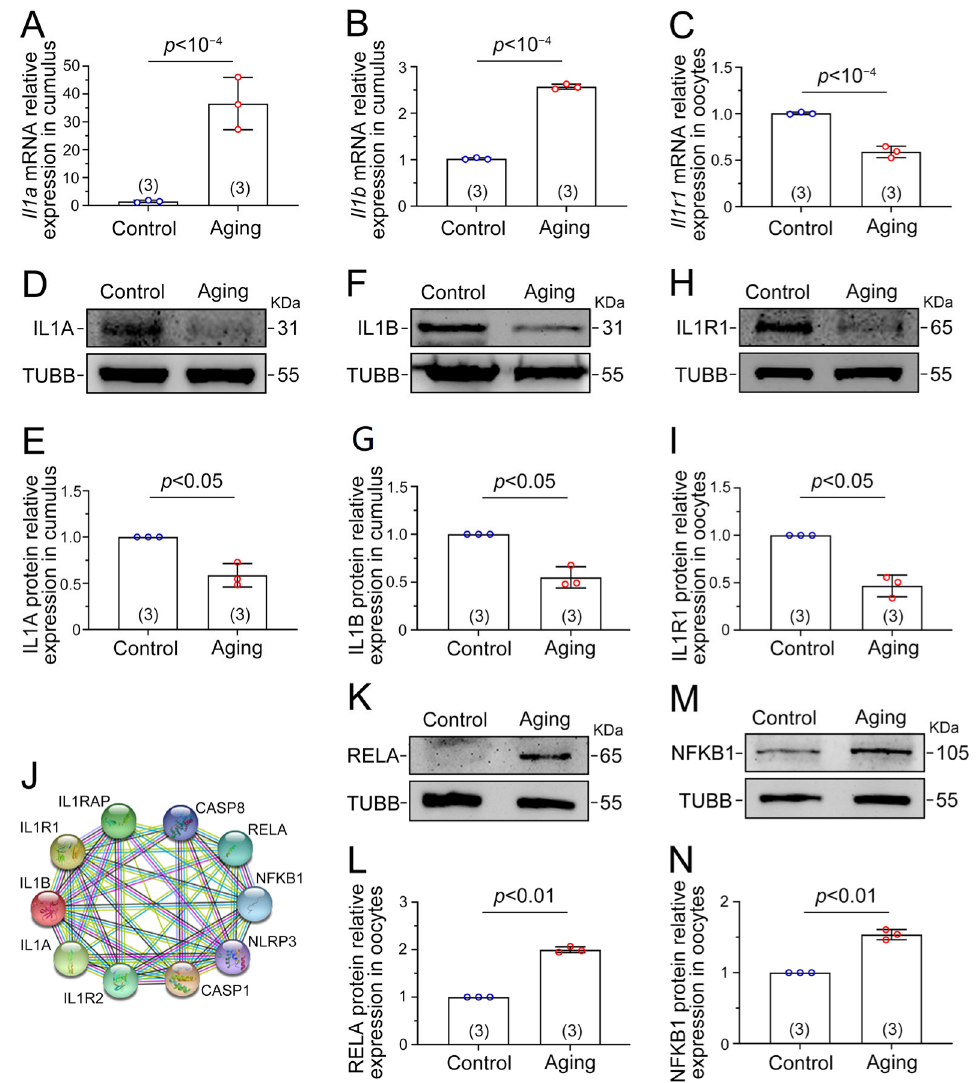
Figure 6. NF- κ B signaling is activated by IL1–IL1R1 interaction. ( A ) Relative Il1a mRNA level in cumulus cells. ( B ) Relative Il1b mRNA level in cumulus cells. ( C ) Relative Il1r1 mRNA level in oocytes. ( D ) The expression level of IL1A protein in cumulus cells. ( E ) The quantified intensity of IL1A/TUBB. ( F ) The expression level of IL1B protein in cumulus cells. ( G ) The quantified intensity of IL1B/TUBB. ( H ) The expression level of IL1R1 protein in oocytes. ( I ) The quantified intensity of IL1R1/TUBB. ( J ) The string diagram shows the protein–protein interaction network. ( K ) The expression level of RELA protein in oocytes. ( L ) The quantified intensity of RELA/TUBB. ( M ) The expression level of NFKB1 protein in oocytes. ( N ) The quantified intensity of NFKB1/TUBB. Each lane requires 200 oocytes or corresponding cumulus cells for the protein detection mentioned above. Expression of TUBB was applied as the interior control. The data are presented as mean ± SD. p < 0.05 indicates a statistically significant difference. The number of experiments is marked in brackets in the